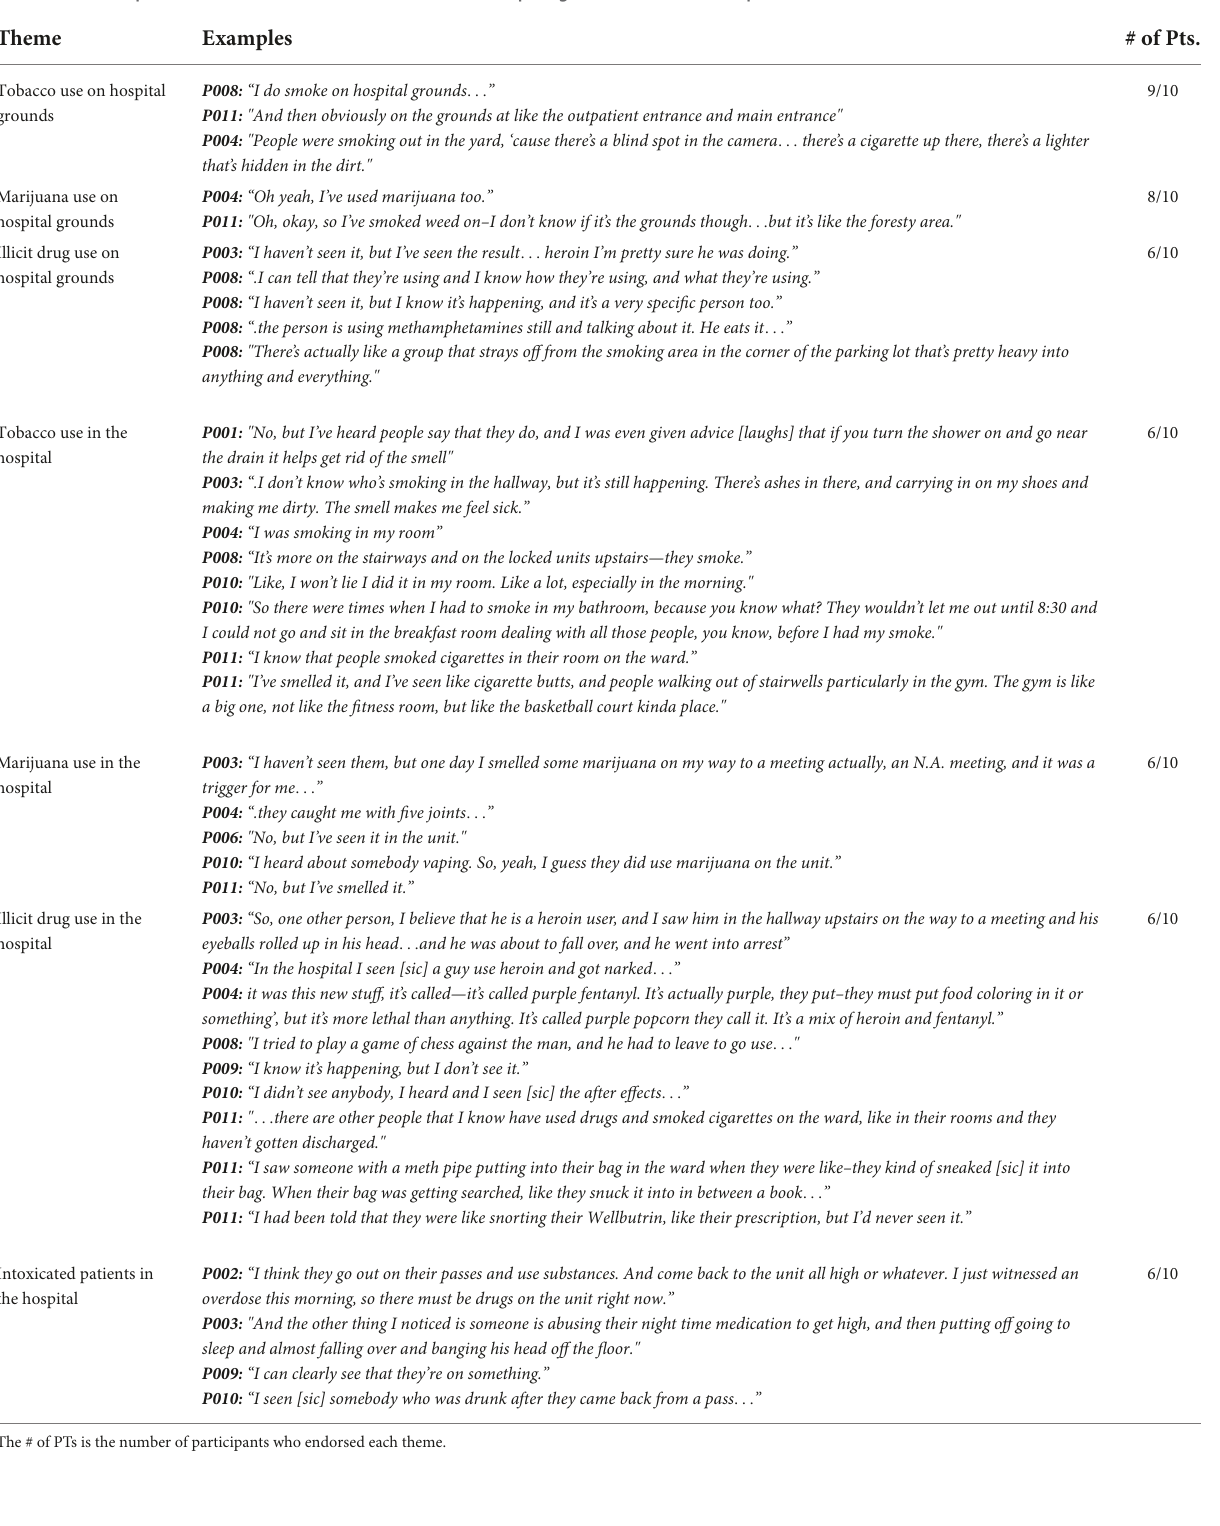
Table 2 for specific examples of contraband substance use on hospital grounds.